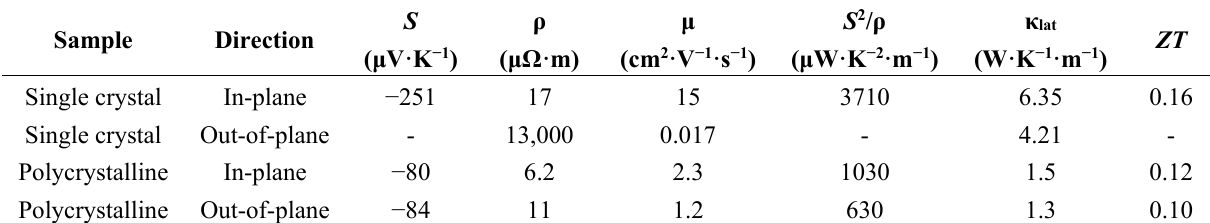
temperature in the in-plane ( ab -plane) and out-of-plane ( c -axis) directions for a single crystal of nearly stoichiometric TiS 2 [40] and polycrystalline Ti 1.008 S 2